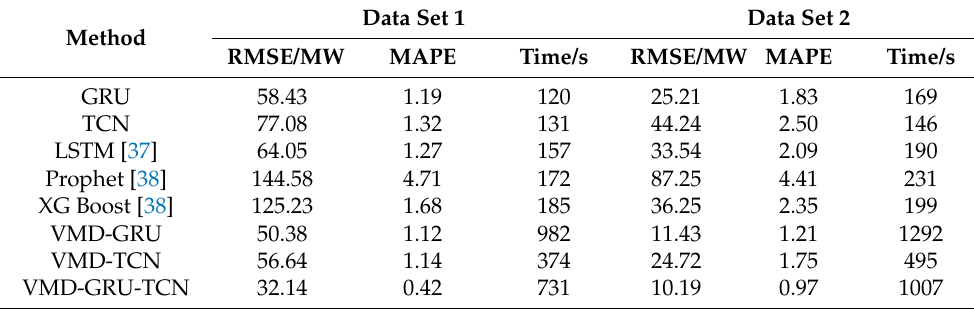
Table 3. Comparison of different forecasting methods.